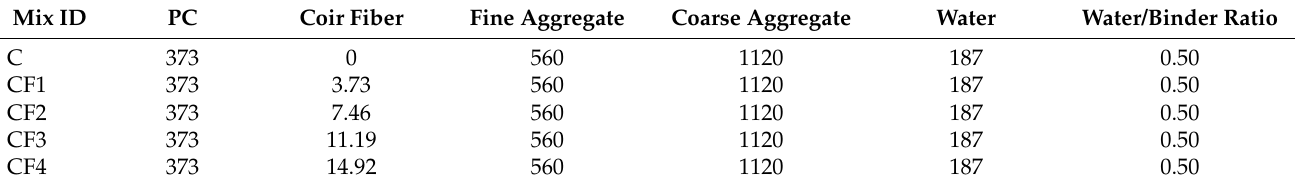
Table 4. Mixture proportions of concrete (kg/m 3 ).